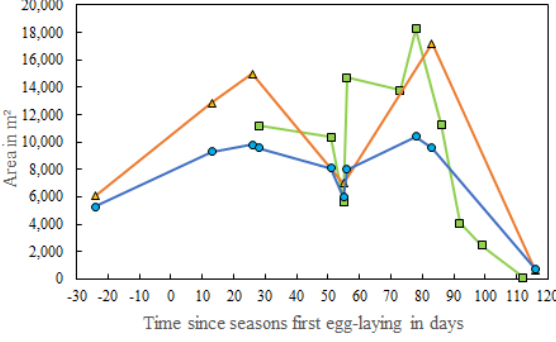
Figure 5. Season 2016/17: different selective classification